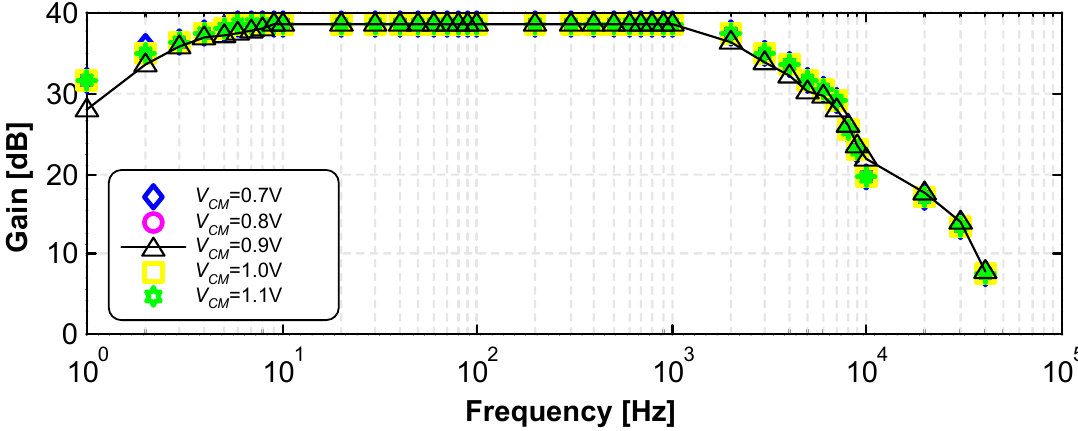
Figure 12. Measured gain in terms of the common-mode voltage V CM .